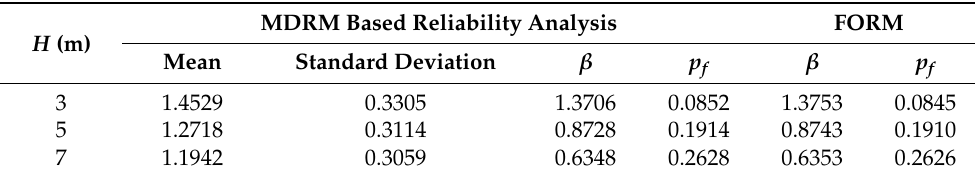
Table 5. Reliability index and failure probability of slope in different θ .